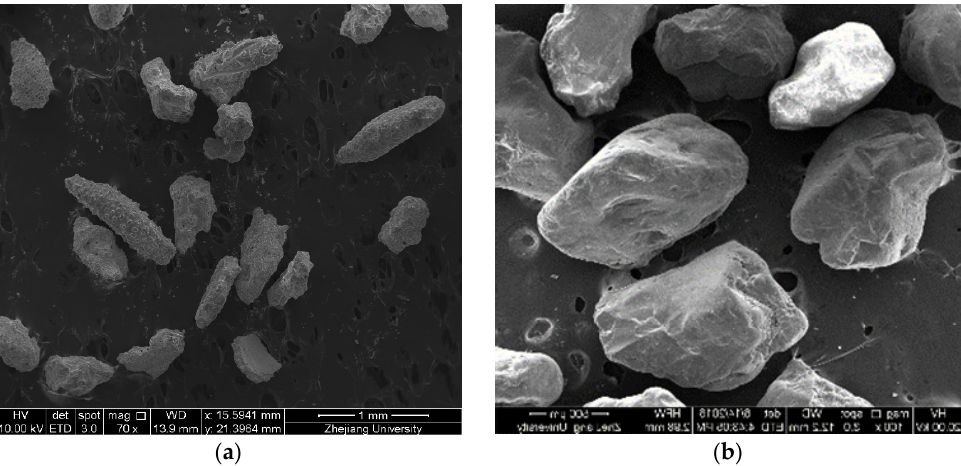
Figure 2. SEM images of calcareous sand and quartz sand: ( a ) Calcareous sand; ( b ) Quartz sand.